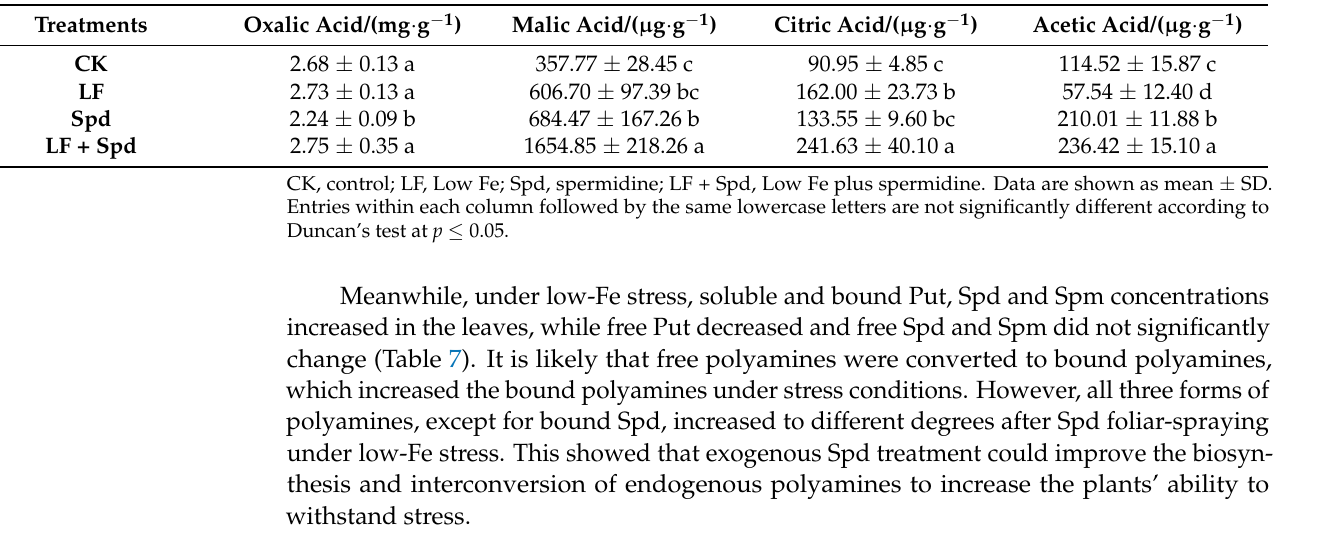
Table 7. Effects of exogenous Spd on the polyamine content in tomato leaves under low-iron stress.